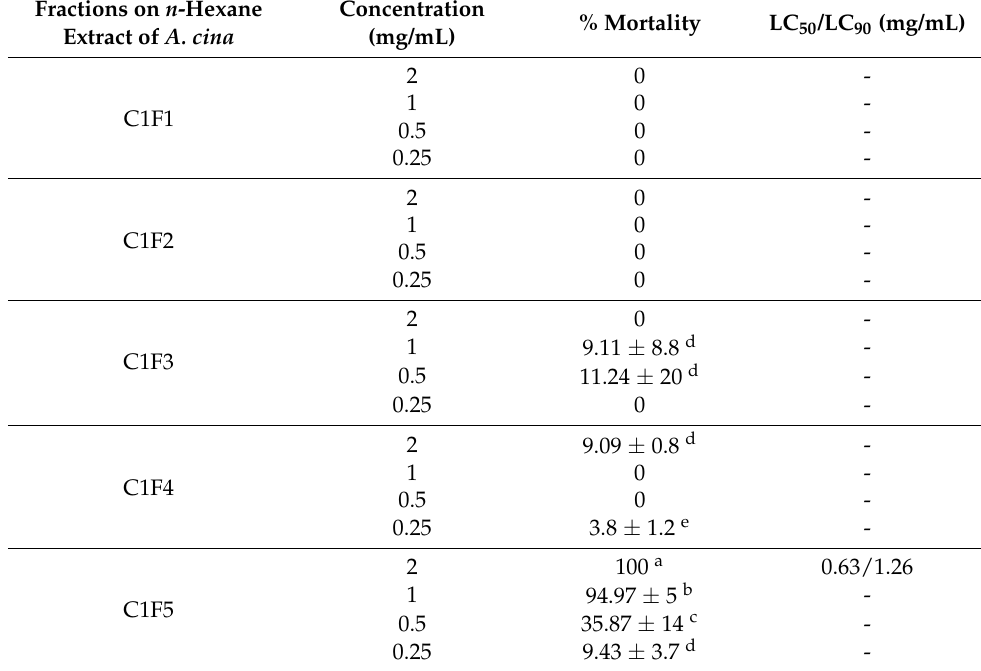
Table 2. In-vitro mortality percentages attributed to the effect of seven n -hexane A. cina fractions against H. contortus infective larvae. Fractions on n -Hexane Extract of A.